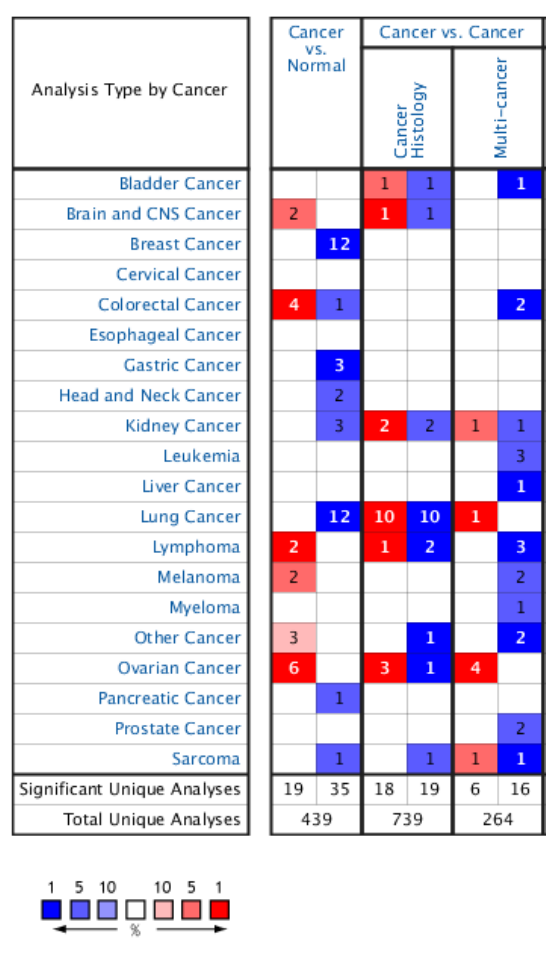
Figure 1: FOLR1 expression in multiple cancers from comparing tumor with healthy control tissue in the Oncomine